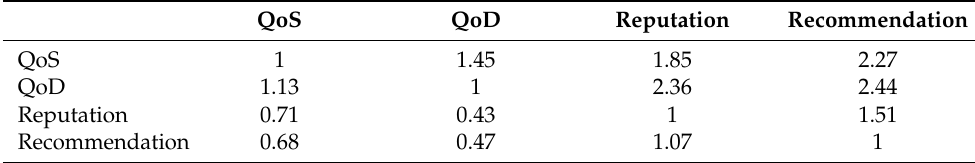
Table 7. Fuzzified Crisp Matrix for Scenario 1.